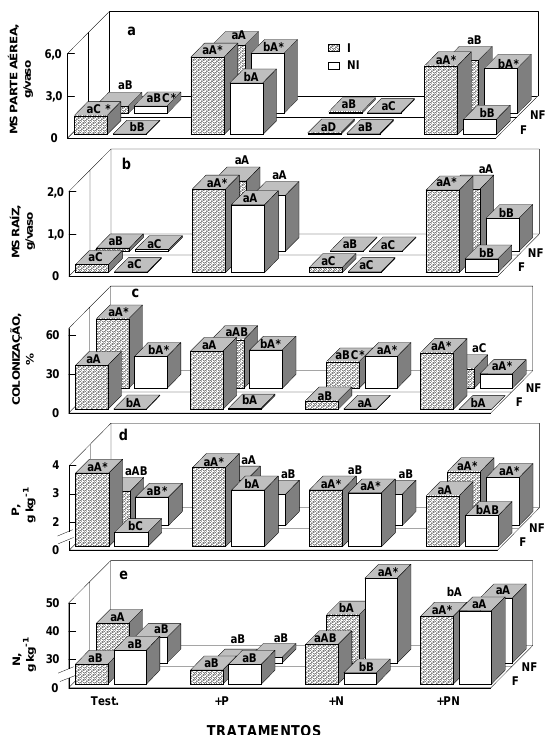
Figura 4. Parâmetros de crescimento, colonização micorrízica e teores de N e P na massa seca da parte aérea da trema em resposta à inoculação com Glomus etunicatum (I- inoculado; NI- não inoculado) em solo fumigado (F) e não fumigado (NF) e adubado com nitrogênio (N), fósforo (P) e PN. Médias seguidas pelas mesmas letras (maiúsculas comparam adubação e minúsculas comparam inoculação) não diferem pelo teste de Tukey a 5%. * Efeito significativo pelo teste de Tukey a 5% para